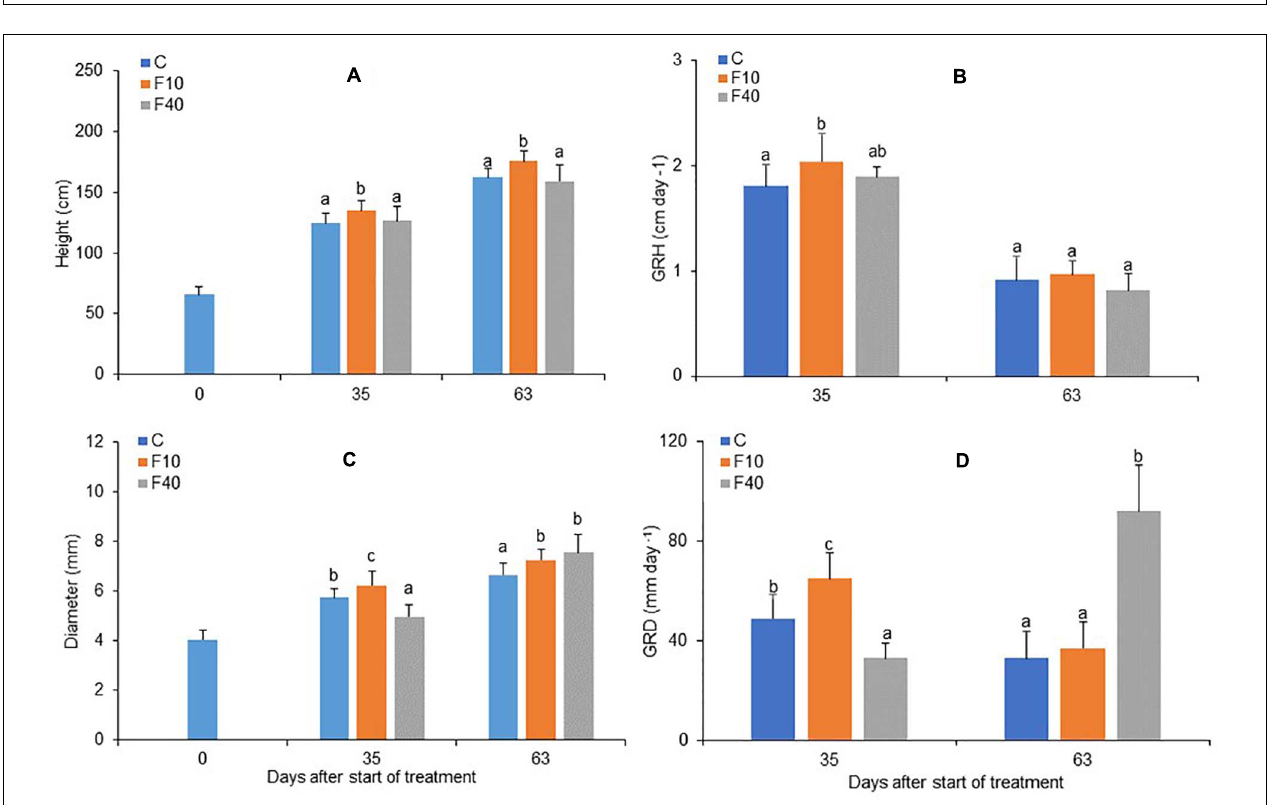
FIGURE 3 | Height (A) , growth rate in height (B) , diameter (C) and growth rate in diameter ( D , multiplied by 10 3 ) for Control, F10 and F40 treatments at the beginning of the experiment (Day 0), at the end of the flooding period (Day 35), and at the end of the post-flooding recovery period (Day 63). Growth rates were calculated for the whole flooding and post-flooding periods. Means followed by the same letter did not differ according to Tukey’s test ( p < 0.05, N = 12–22). Vertical bar: standard deviation.